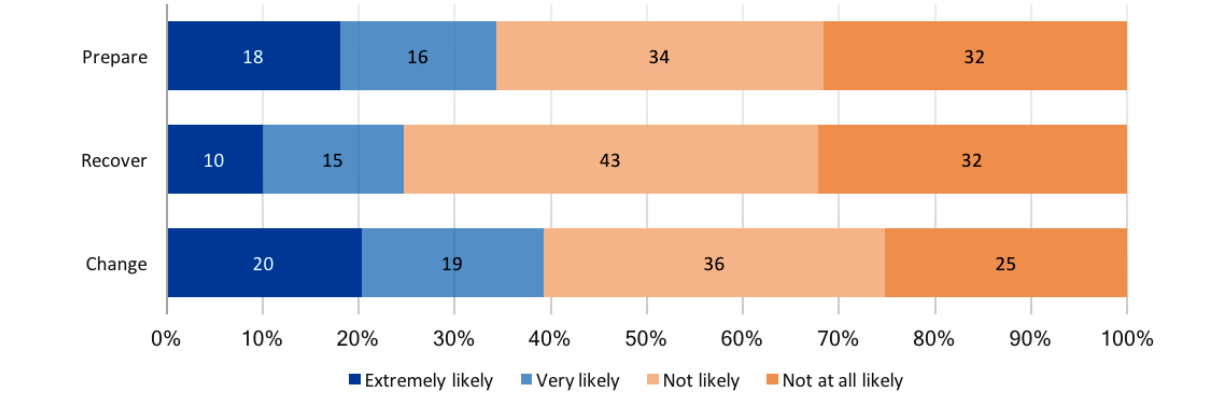
Fig. 1 . Subjective self-evaluations of resilience-related capacities to extreme flooding in